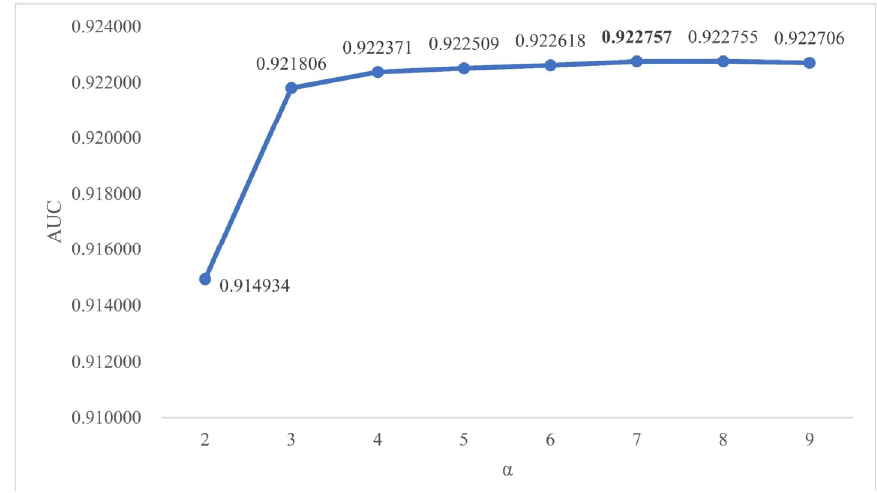
Figure 4. The AUC results of FCV when α with different values.